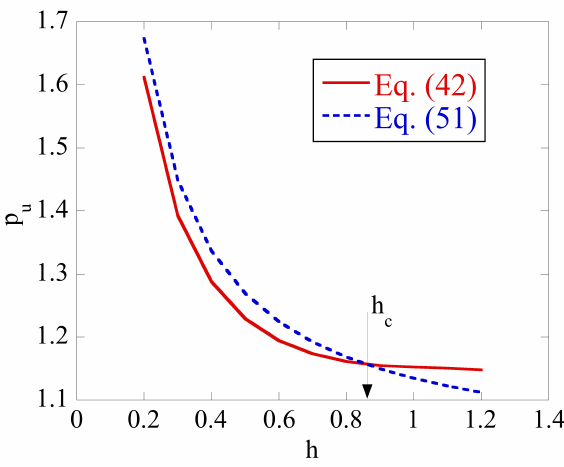
Figure 3. Existence of a critical value of h at which solutions (42) and (51) provide the same limit load for the isotropic material at m = 0.7.